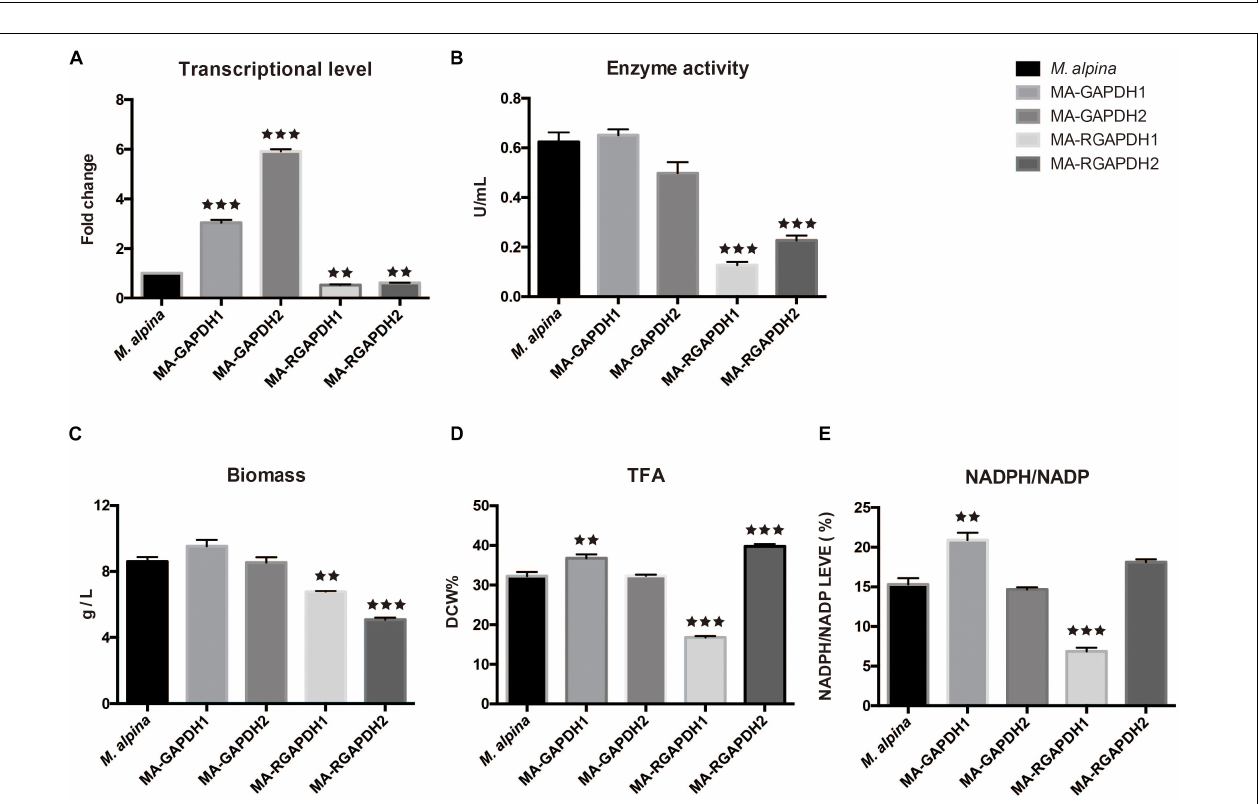
FIGURE 3 | Effect of GAPDH1 and GAPDH2 on lipid biosynthesis (A) transcriptional level analysis; (B) enzyme activity analysis; (C) biomass analysis; (D) total fatty acid (TFA) analysis; (E) NADPH level analysis. ** represents p < 0.01, *** represents p < 0.001.